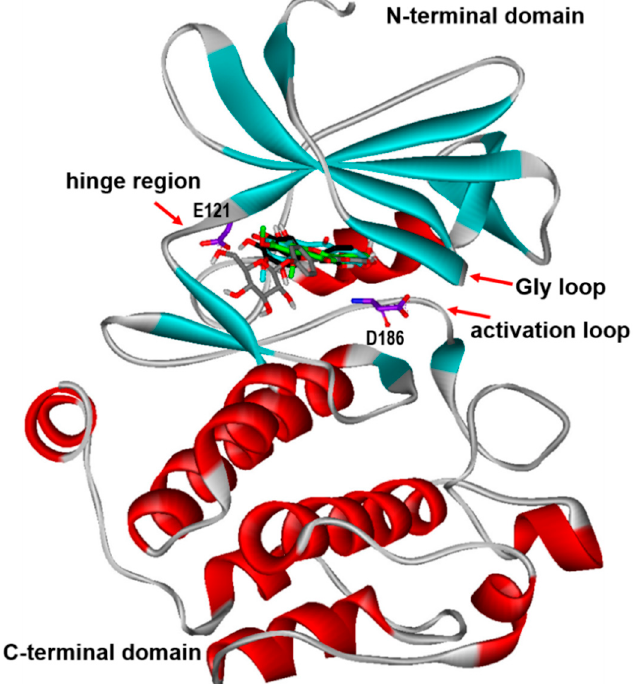
Figure 3. Comparative view of the calculated binding modes of 1–4 in the ATP-binding site of PIM1. The carbon atoms of PIM1, 1 , 2 , 3 , and 4 are indicated in violet, green, cyan, black, and gray, respectively. The positions of Glu121 in the hinge region and Asp186 in the activation loop are also indicated.